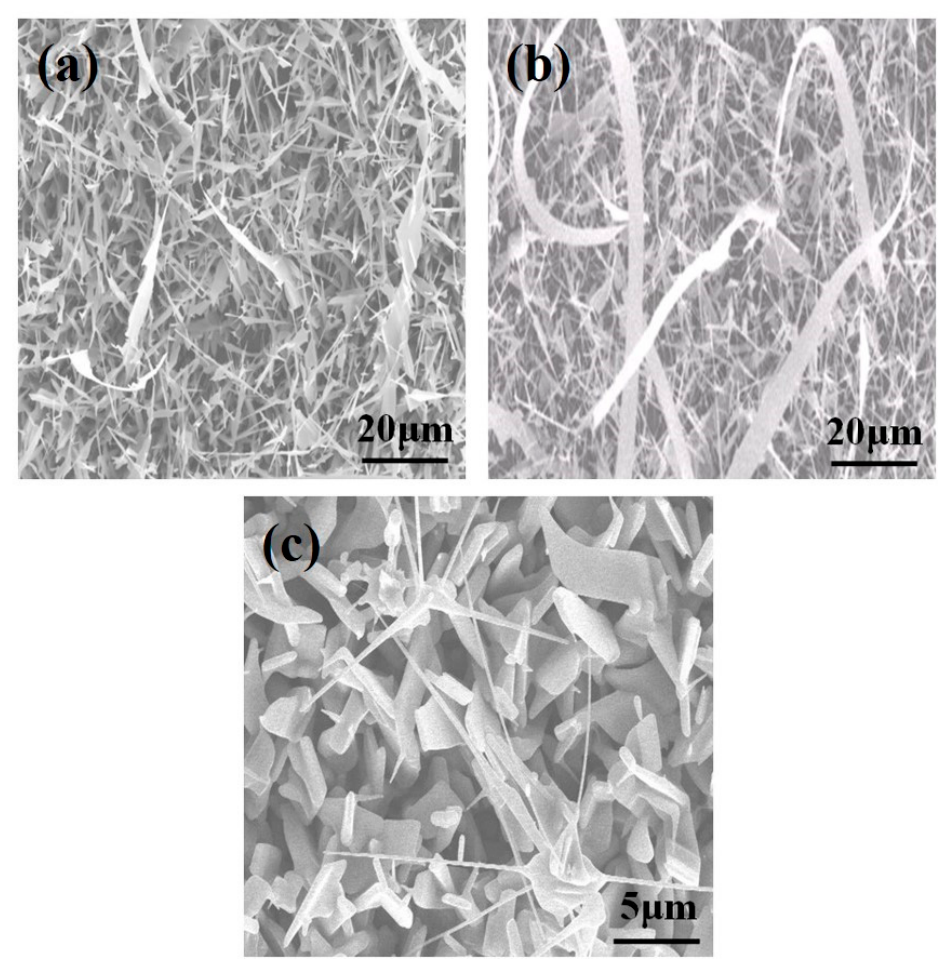
Figure 5. FE-SEM images of ZnO nanostructures grown in perpendicular setup on Si substrates without Au catalyst as function of growth temperature at a Ar / O 2 flow rate of 120 / 1.0 sccm in gas mixture: ( a ) 700 °C, ( b ) 800 °C, and ( c ) 900 °C.